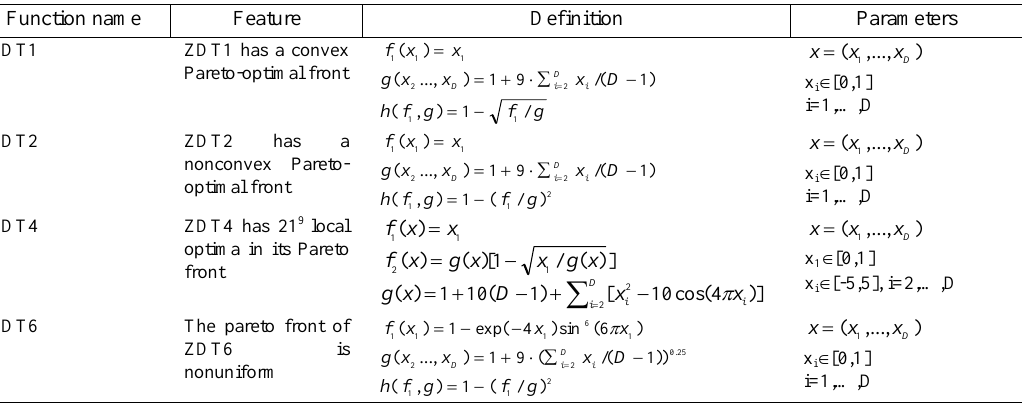
Table 1. Table 1. Benchmark